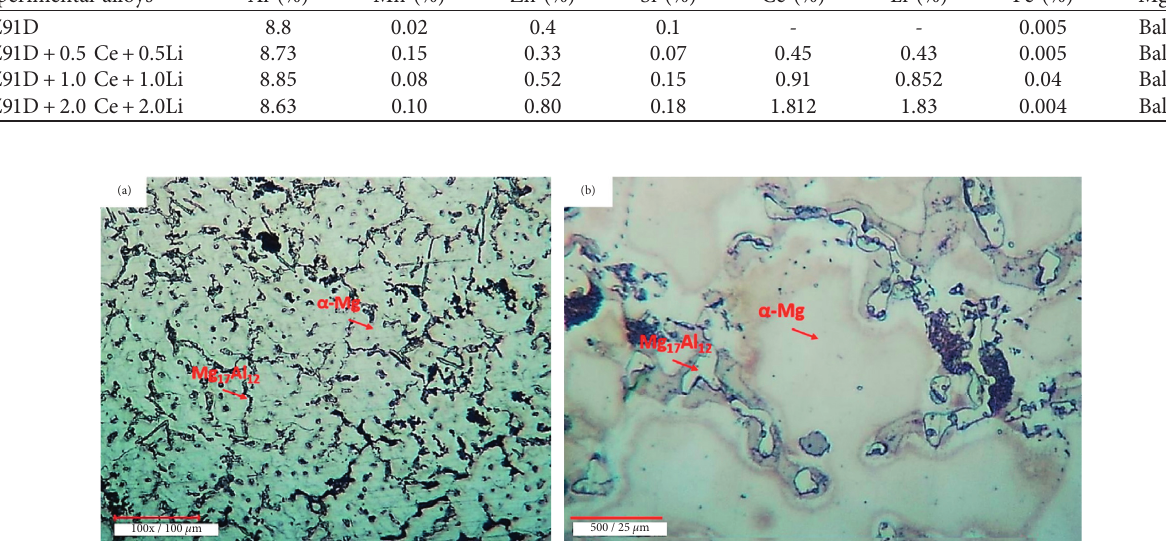
Figure 1: Microstructure of AZ91D: (a) lower magnification (100 µ m); (b) higher magnification (25 µ m).